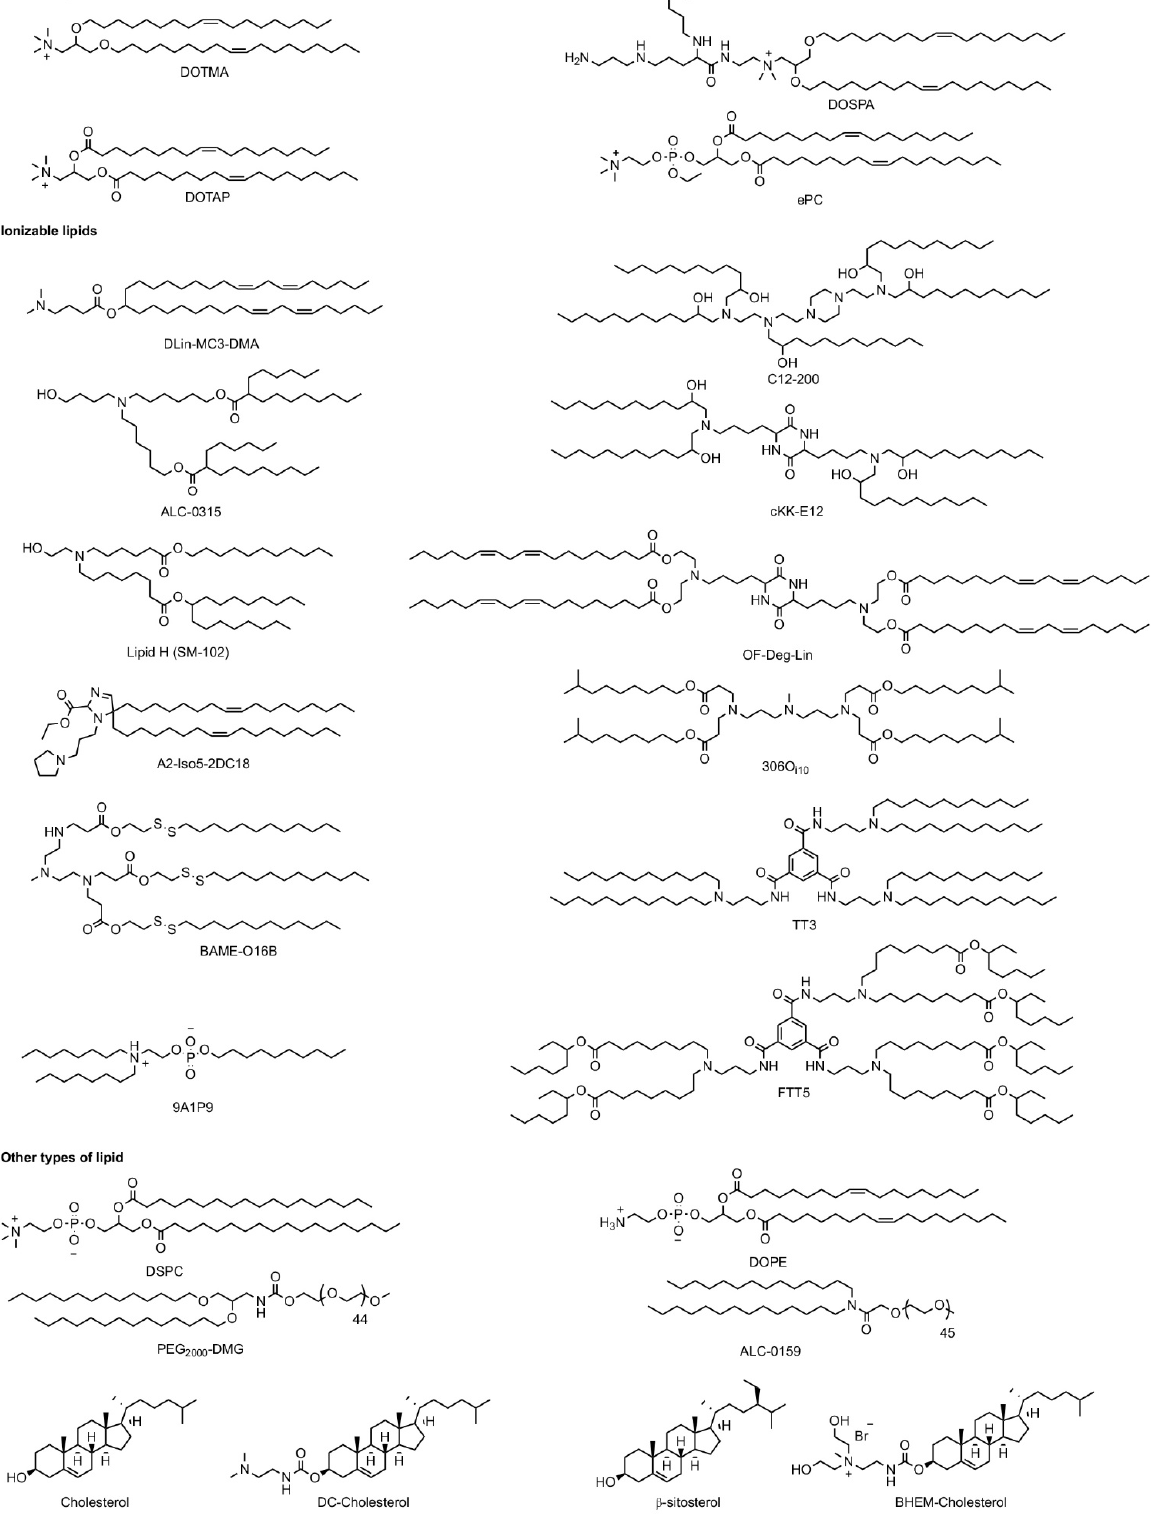
Figure 3. Chemical structures of lipids and lipid derivatives used for mRNA delivery. Reprinted with permission from [65] .